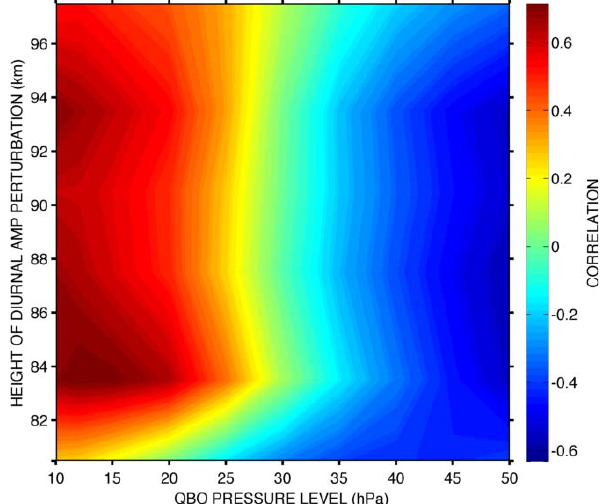
bations and stratospheric QBO winds as a function of height and pressure